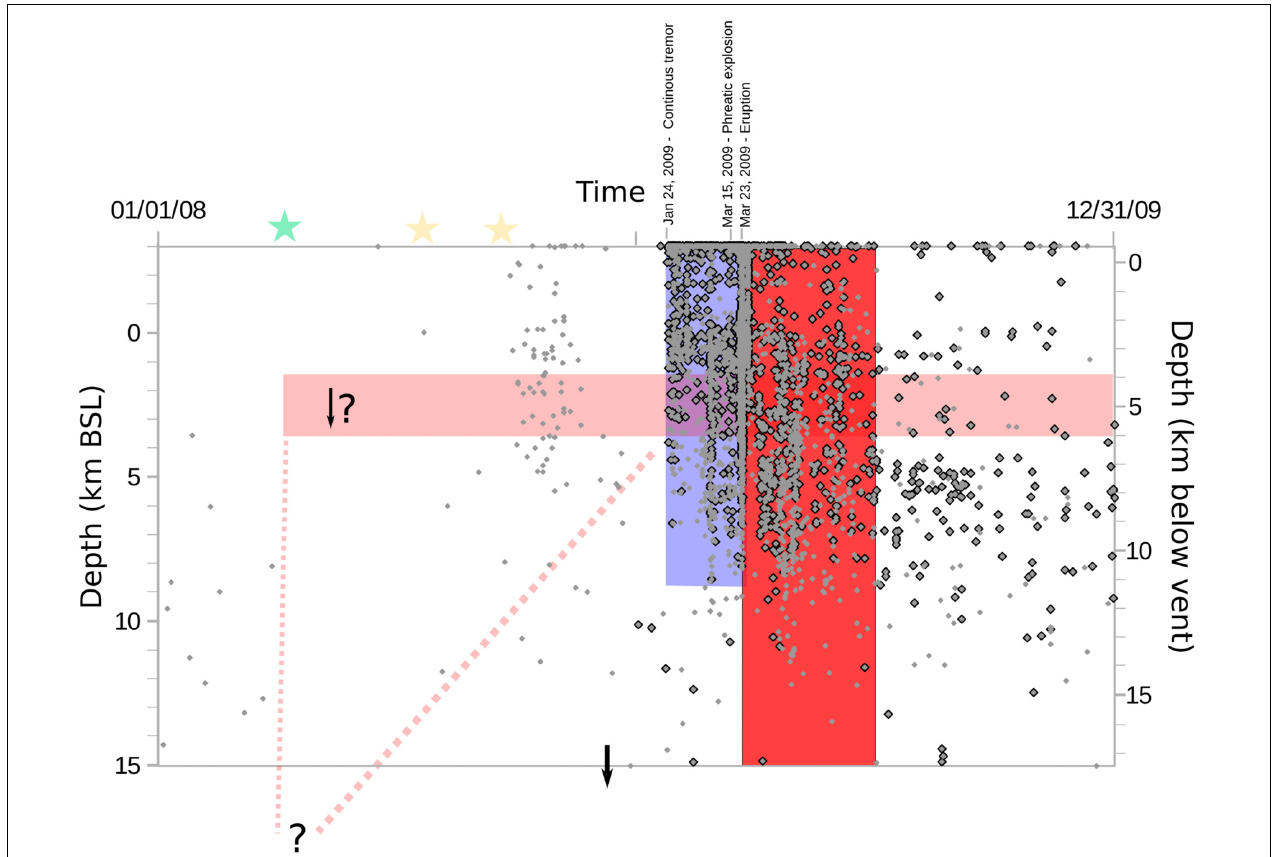
FIGURE 4 | Time-depth plot for Redoubt Volcano, Alaska from January 2008 to December 2009. Light red – petrologically-defined magma source. Dark red – eruptions. Light blue shading shows the timing and depth of precursory seismicity. Gray dots show all earthquakes and black outlined dots show earthquakes with well-constrained locations. Green star indicates onset of GPS-detected deformation. Yellow stars indicate timing of first-detected gas and thermal anomalies. Black arrow at base of plot indicates the timing of the start of deep long-period seismicity (not shown in plot). Question marks indicate uncertainty in petrologically-constrained magma storage